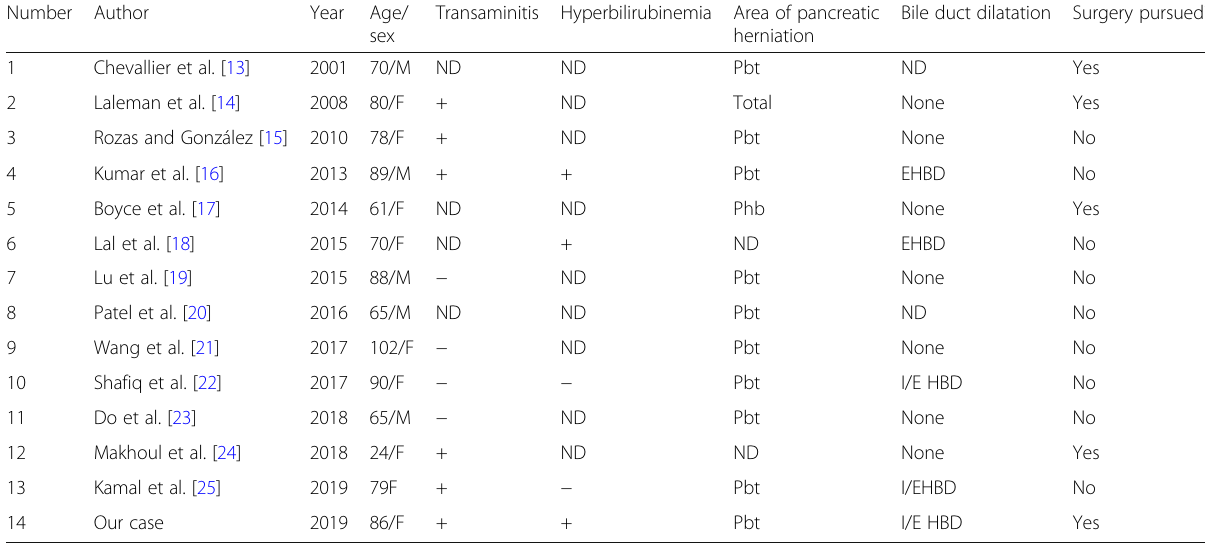
Table 1 Cases of acute pancreatitis caused by the hiatal hernia of the